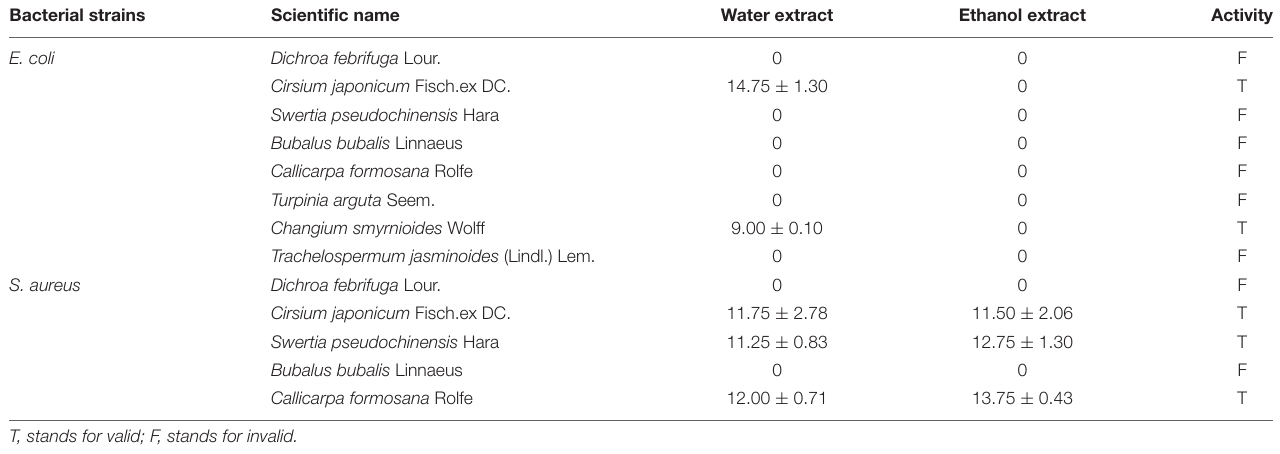
TABLE 3 | Inhibition zone of TCMs extract on E. coli and S. aureus (mm). Bacterial strains Scientific name Water extract Ethanol extract Activity